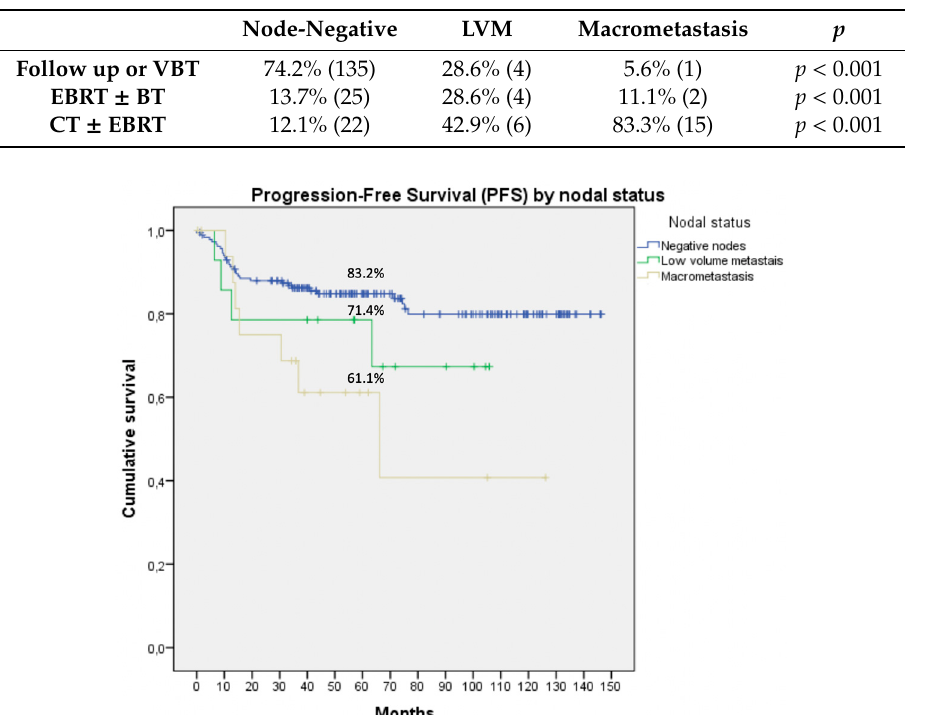
Figure 1. Progression-free survival by nodal status in patients with nodal surgical staging. Significant differences were observed between groups in 5-year PFS ( p =